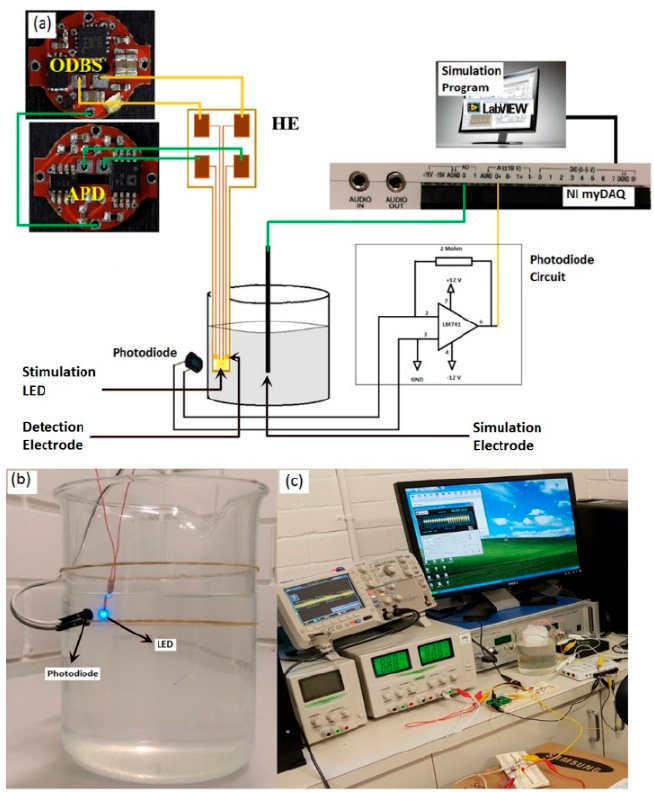
Figure 13. In vitro validation of the CLOS device. ( a ) In vitro setup. ( b ) Photodiode and LED setup. ( c ) In vitro evaluation.